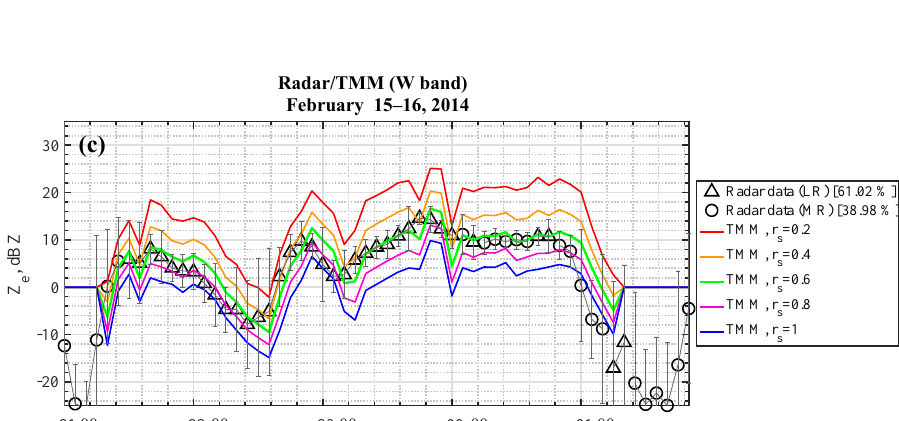
56.67 % for MR and 30 % for HR; Ka/W band: 10.14 % for LR, 65.94 % for MR and 23.91 % for HR). Until 22:00